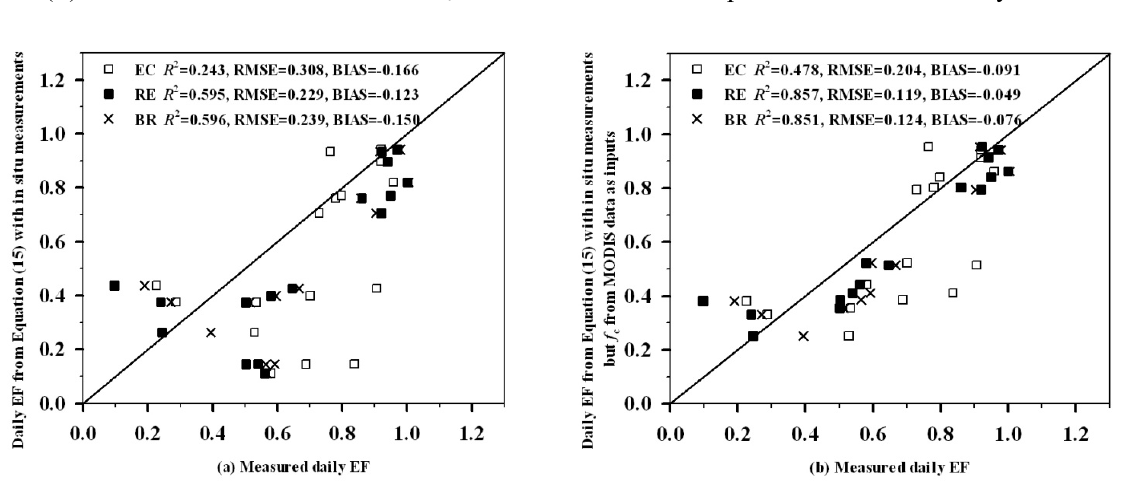
Figure 12. Comparisons of daily EF estimates ( a ) from in situ measurements as inputs and ( b ) from in situ measurements but f from MODIS data as inputs with measured daily EF. c